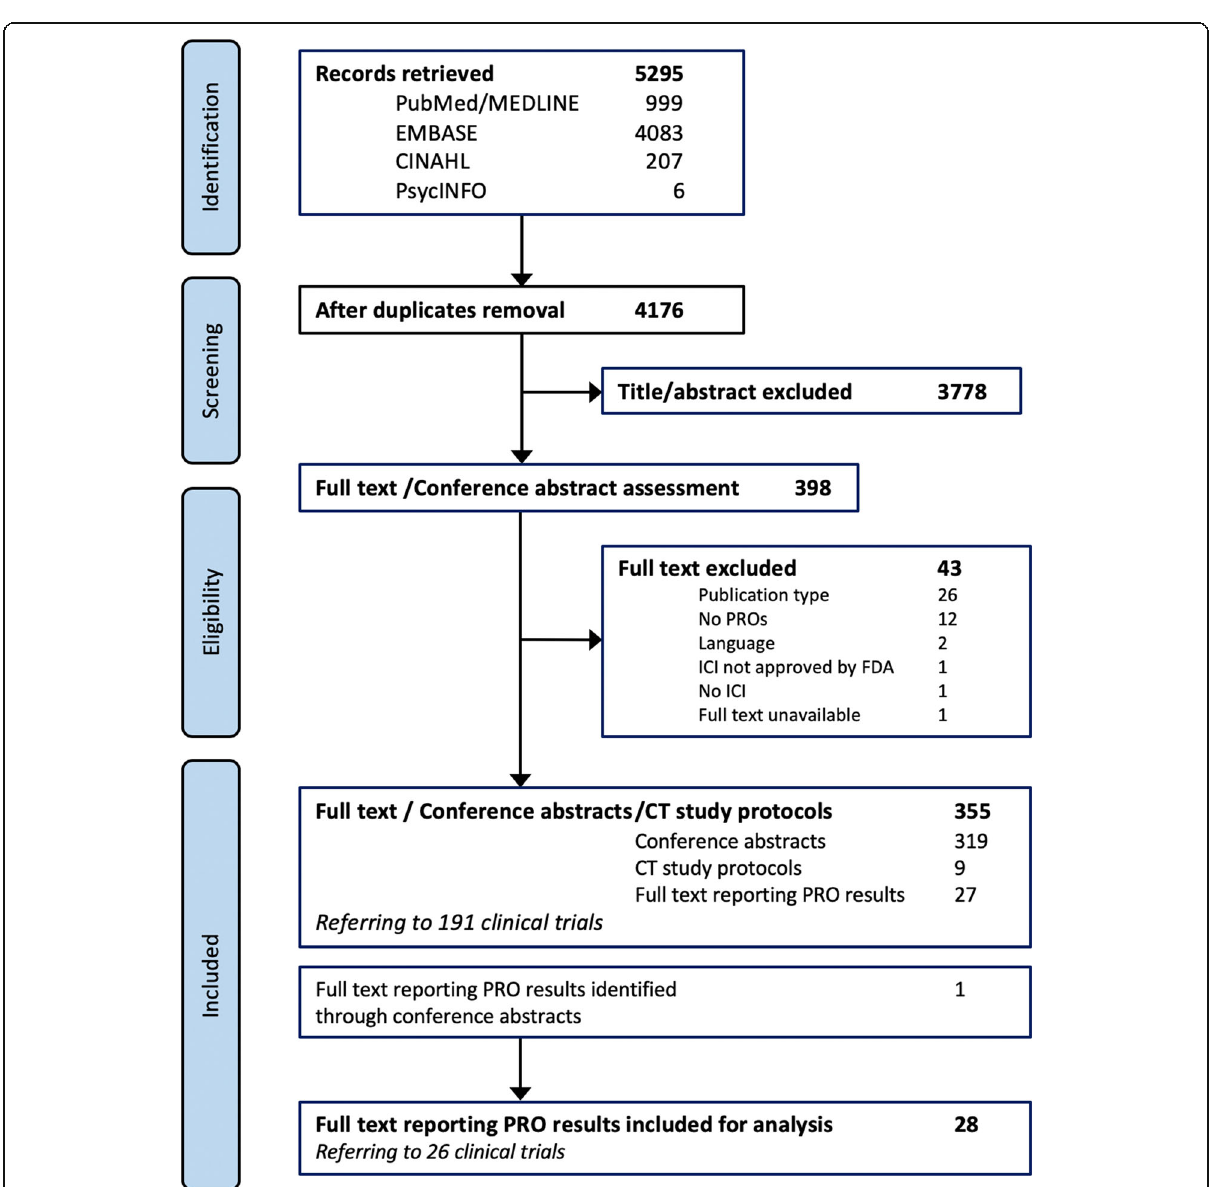
Fig. 1 PRISMA chart mapping the number of records identified, selected, and included for final analysis. Twenty-eight full-text articles reporting PRO results referring to 26 ICI-CTs, 9 study protocols, and 319 conference abstracts stating the use of PRO measures in ICI-CTs, were retained for data